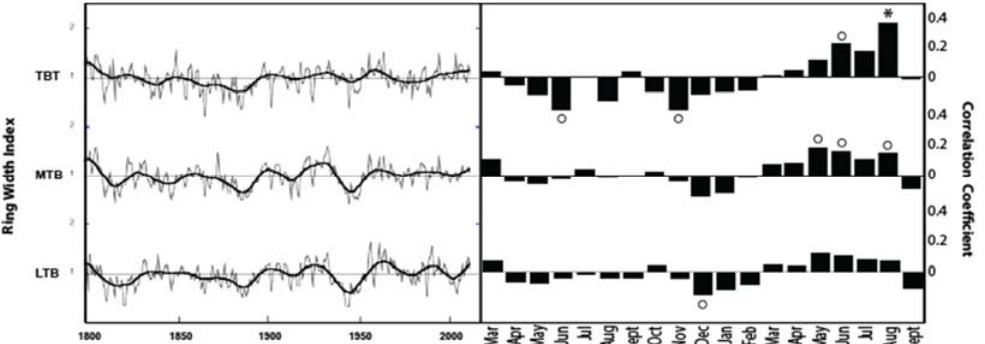
Figure 2. Left, larch chronologies starting from 1800, ordered with respect to increasing altitude (over a 500 meter difference) from bottom to top. EPS statistic is greater than 0.85 for the entire interval shown. Thick line shows values smoothed with a 6% weighted curve. Right, correlations with Klyuchi mean temperature for a 19 month dendroclimatic year, March–December of the previous year through September of the current growth year. ° denotes a correlation significant at a 90% confidence level, whereas * a correlation significant at the 99% confidence level.